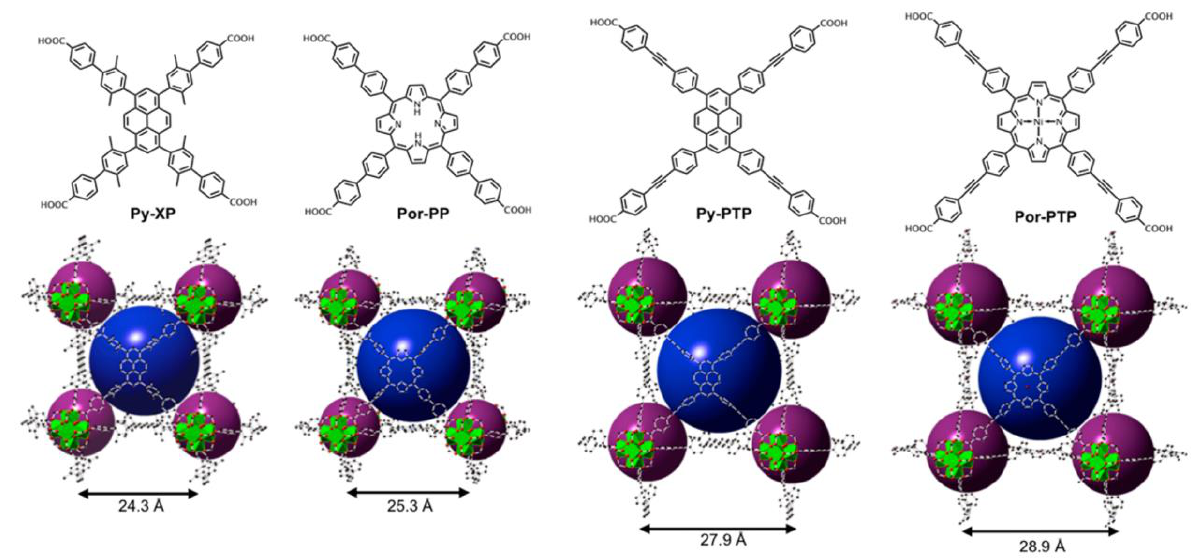
Figure 4. Linkers of NU-1101–NU-1104 and respective pore structures [71]. Adapted from ref. [72] with permission.